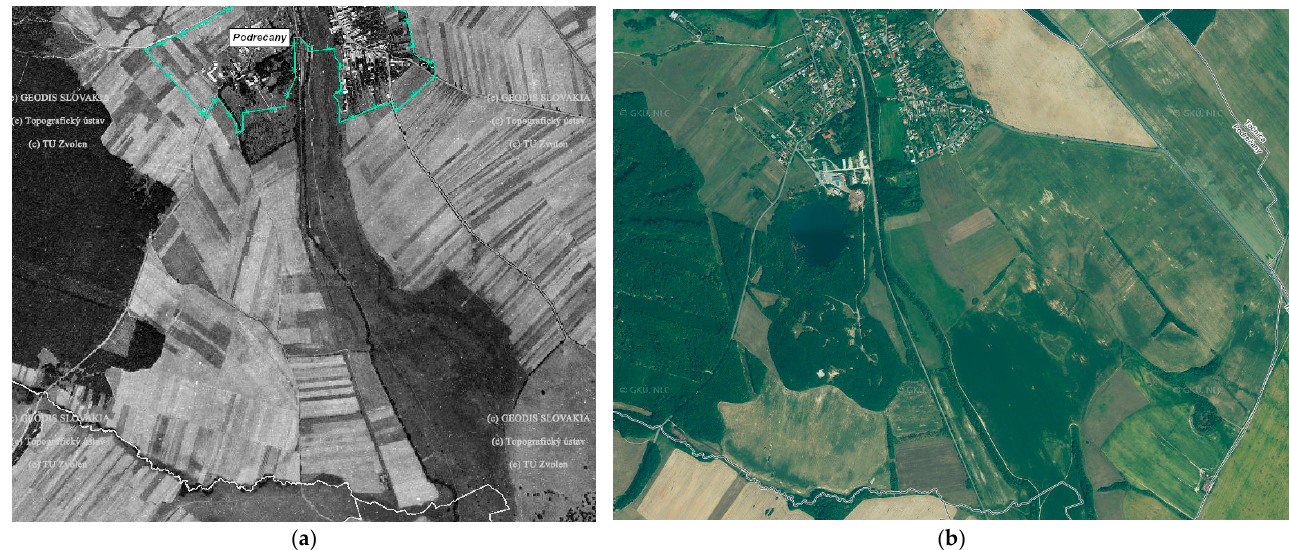
Figure 7. Changes in land use ( a ) 1950 (Source: mapy.tuzvo.sk/HOFM/, accessed on 29 September 2021); ( b ) 2018 (Source: www.geoportal.sk, accessed on 27 September 2021).